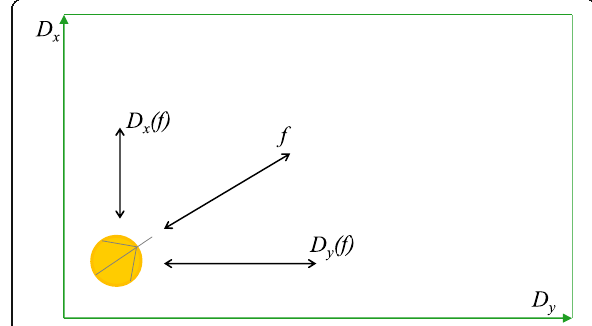
Fig. 2 Spatial domain description of sensor. Figure shows spatial domain description of